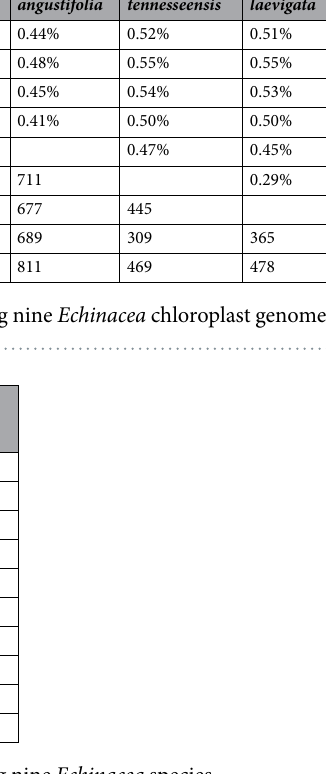
Table 3. The 10 most-divergent coding regions among nine Echinacea